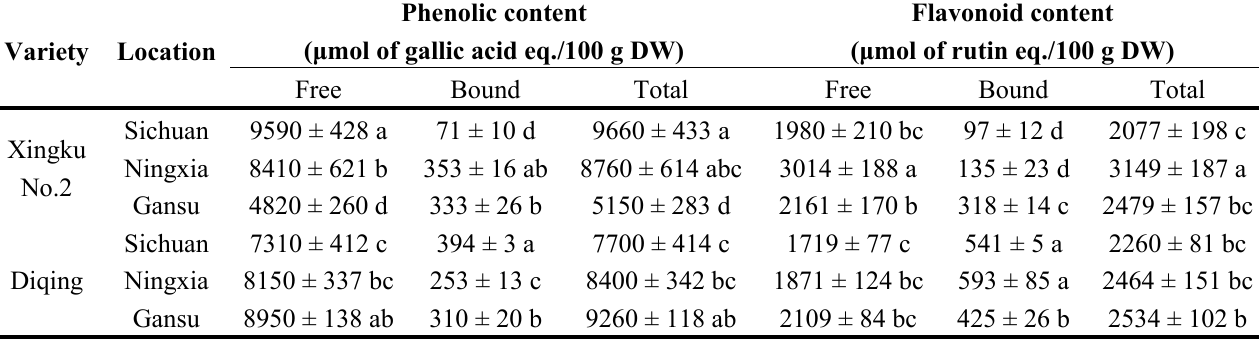
Table 1. Phenolic and flavonoid content of tartary